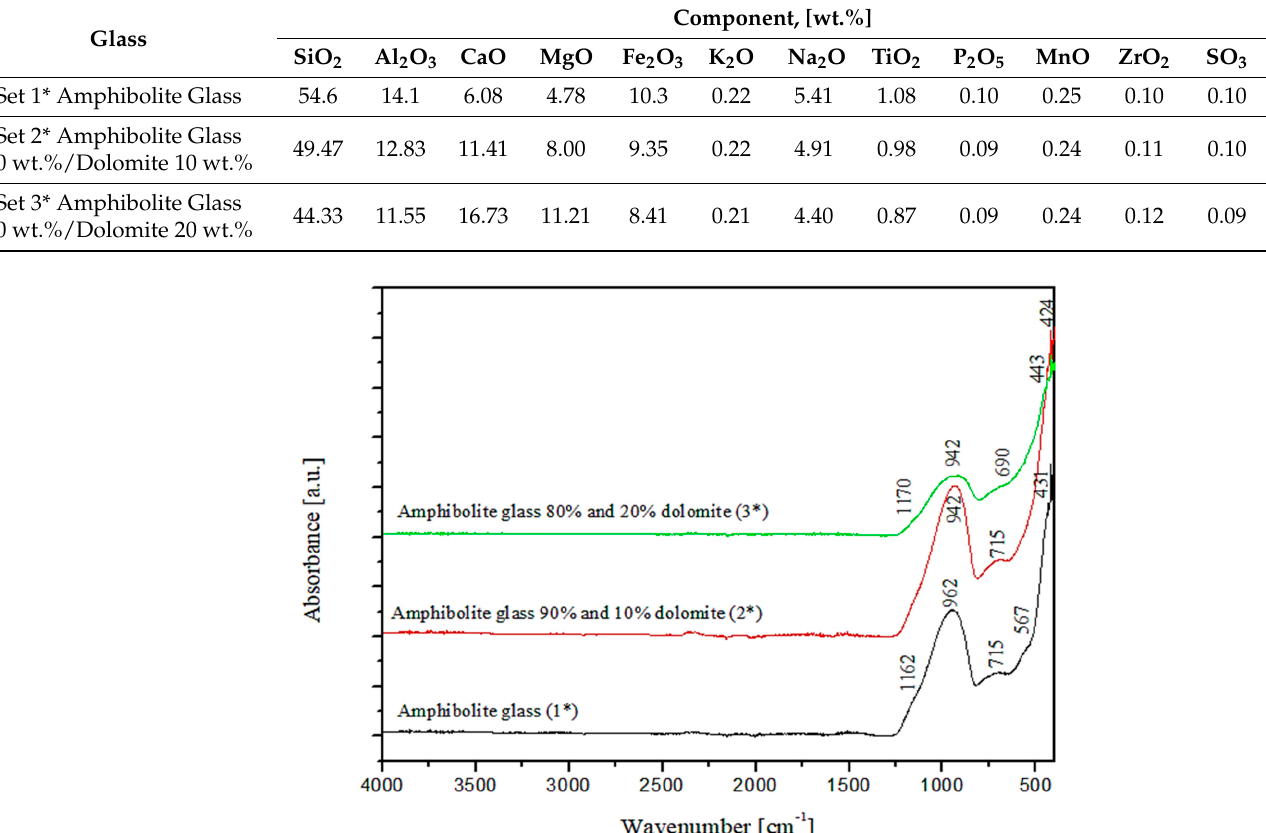
Figure 2. X-ray diffractograms of amphibolite glasses after the melting process. Table 2. Chemical composition of amphibolite glasses after the melting process [wt.%].